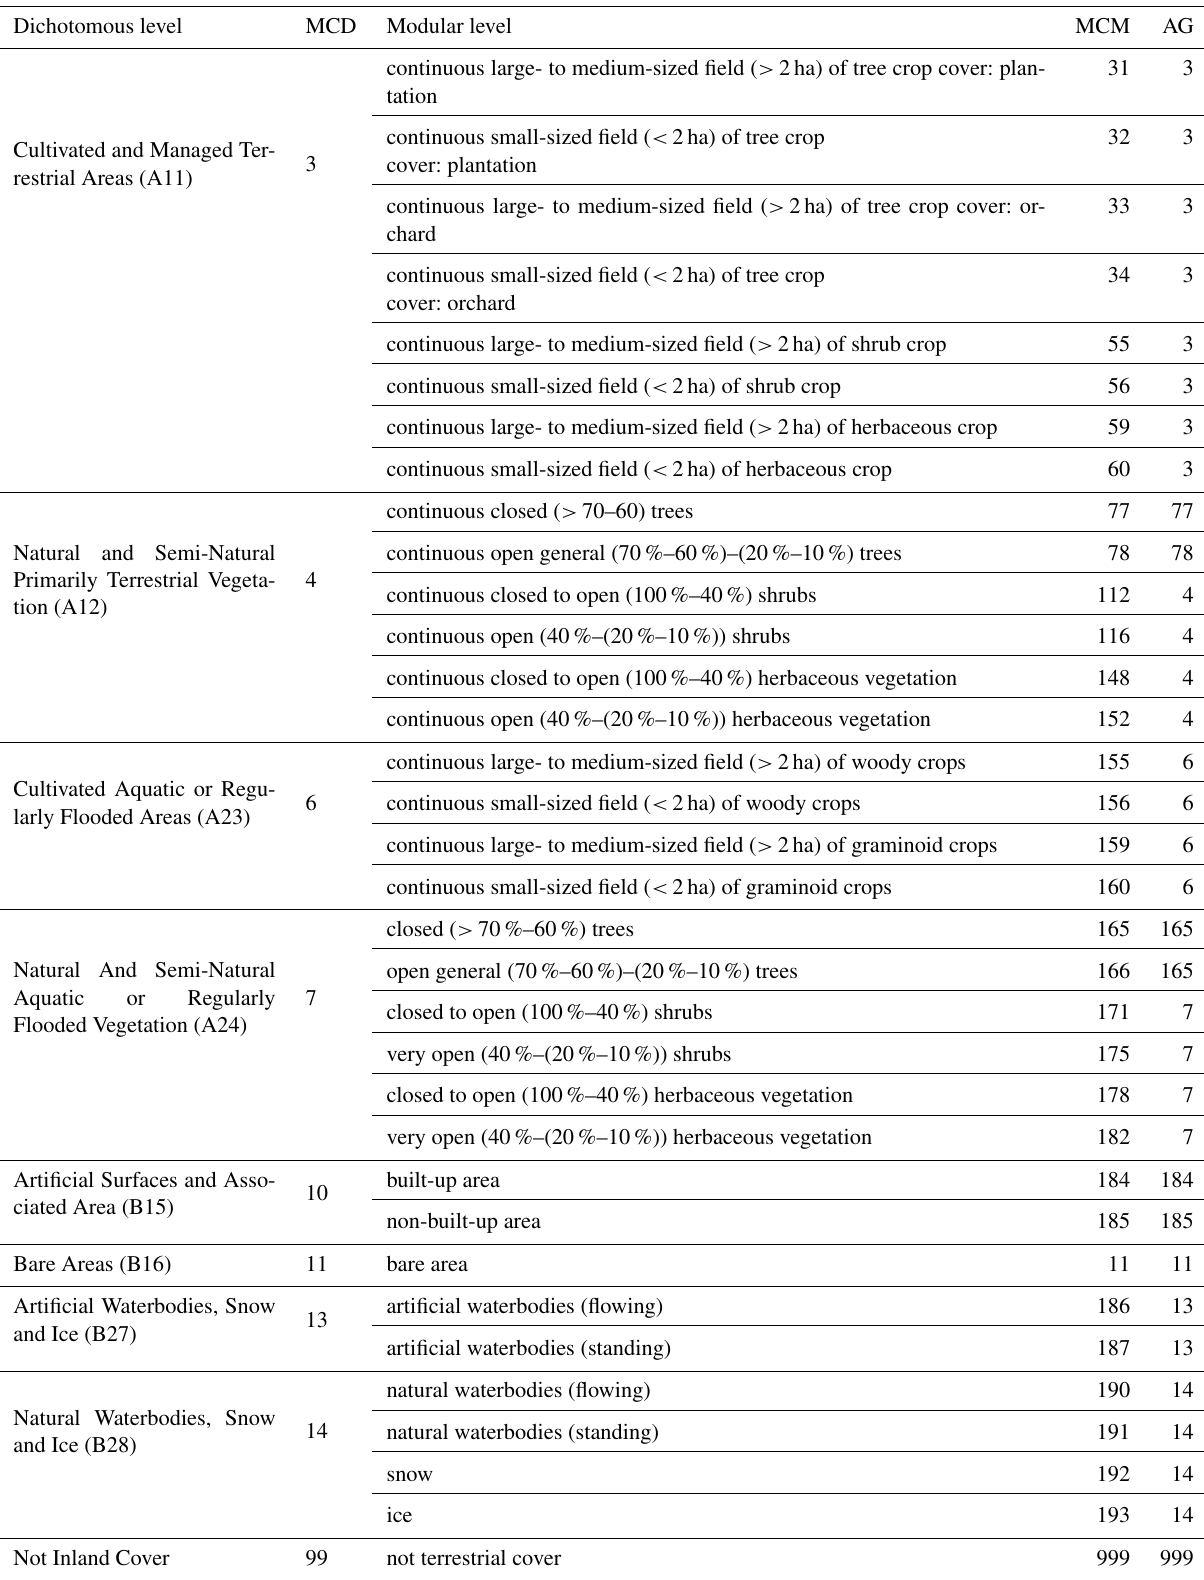
Table 2. Dichotomous and modular thematic land cover/use classes (MCD: mapcode dichotomous level; MCM: mapcode modular level; AG: aggregated classes for land cover change accuracy estimation; see Sect. 3.5 for additional information). Dichotomous